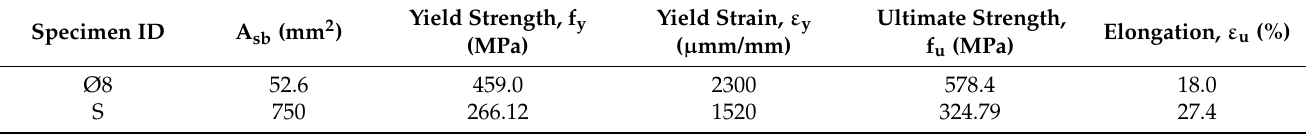
Table 2. Mechanical properties steel